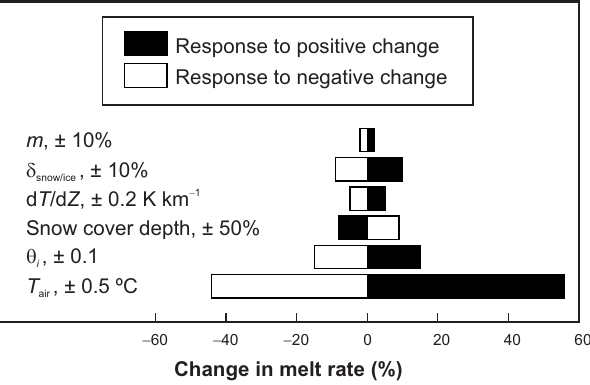
Fig. 9. Change in melt rate for the Hurd Peninsula glaciers resulting from perturbation in various parameters relative to the calibrated run of the 2008/09 AWS